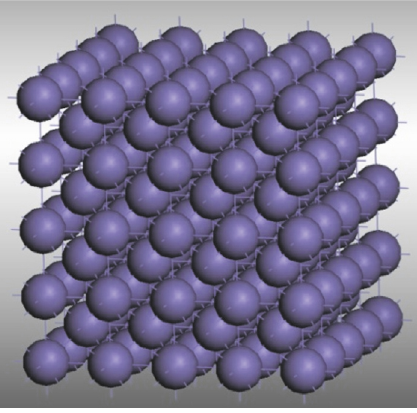
Figure 1: The force-magnetism coupling calculation model.